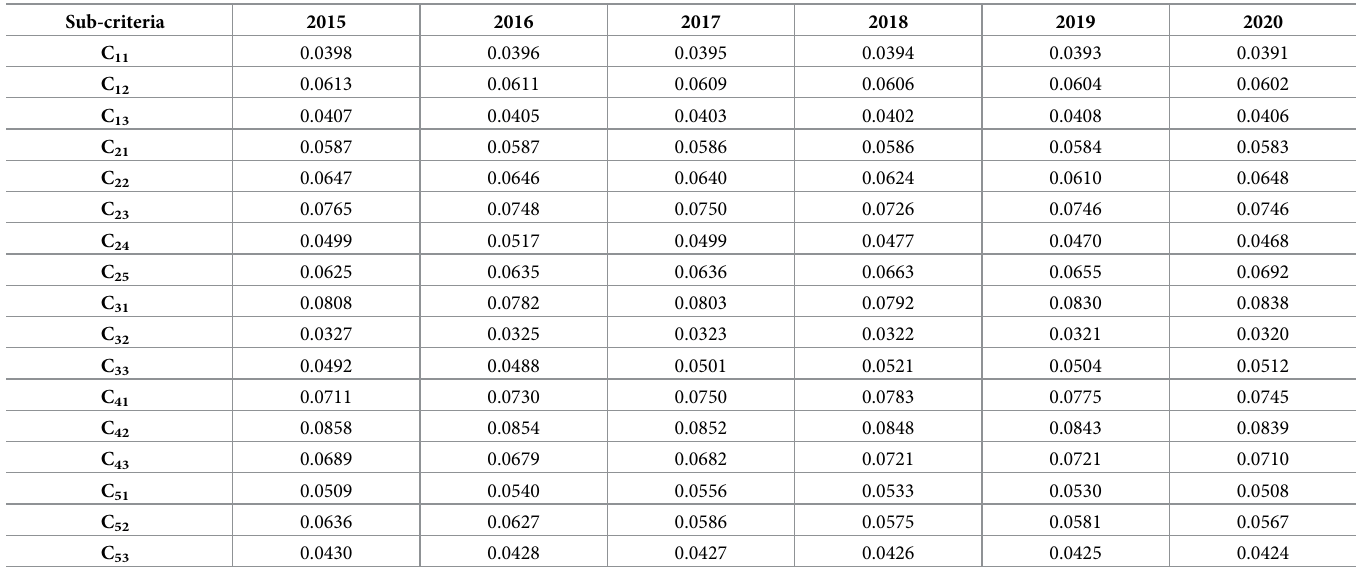
Table 8. Integrated weights for all indicators regard of different years.